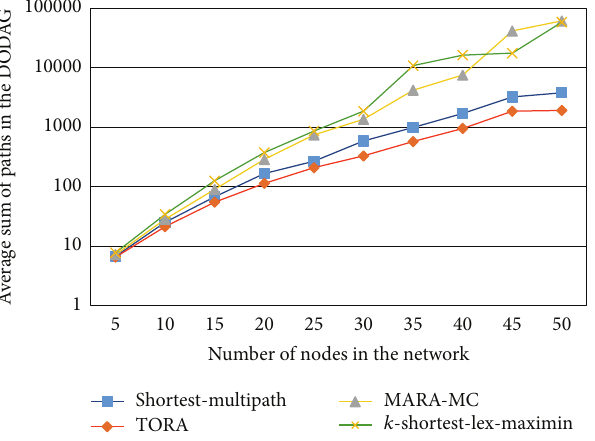
Figure 2: Relative comparison of the three algorithms for 10-node networks using the lexicographic 𝑘 -shortest solution as a reference. Δ𝑈 values are relative to the reference (lexicographic) solution. to grade the nodes at the same hop count distance from the root; hence, a significant fraction of edges is assigned at